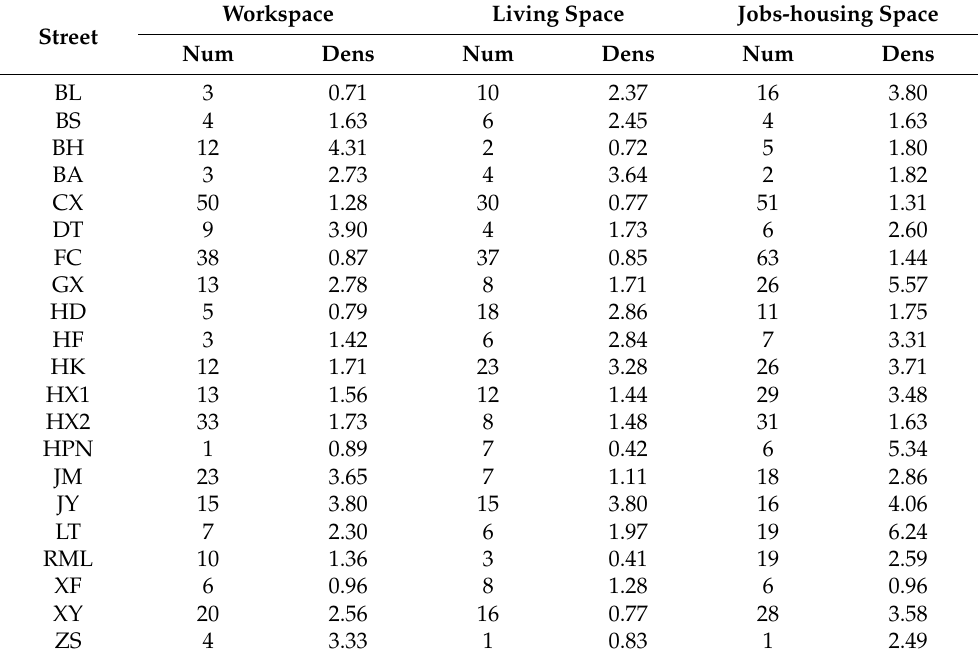
Table 4. Statistics on the number and density (/km 2 ) of street land